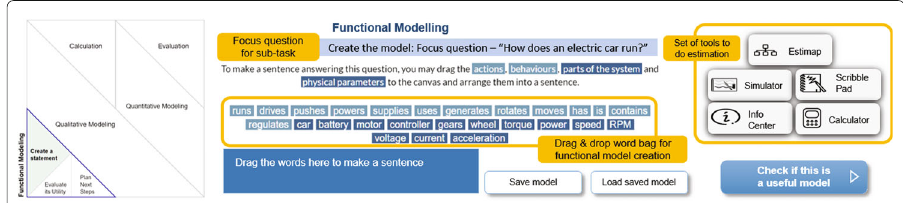
and begin doing the task. The Estimap offers the learner the flexibility to choose tasks and thus his/her solution path. There was a short introductory video describing what the Estimap